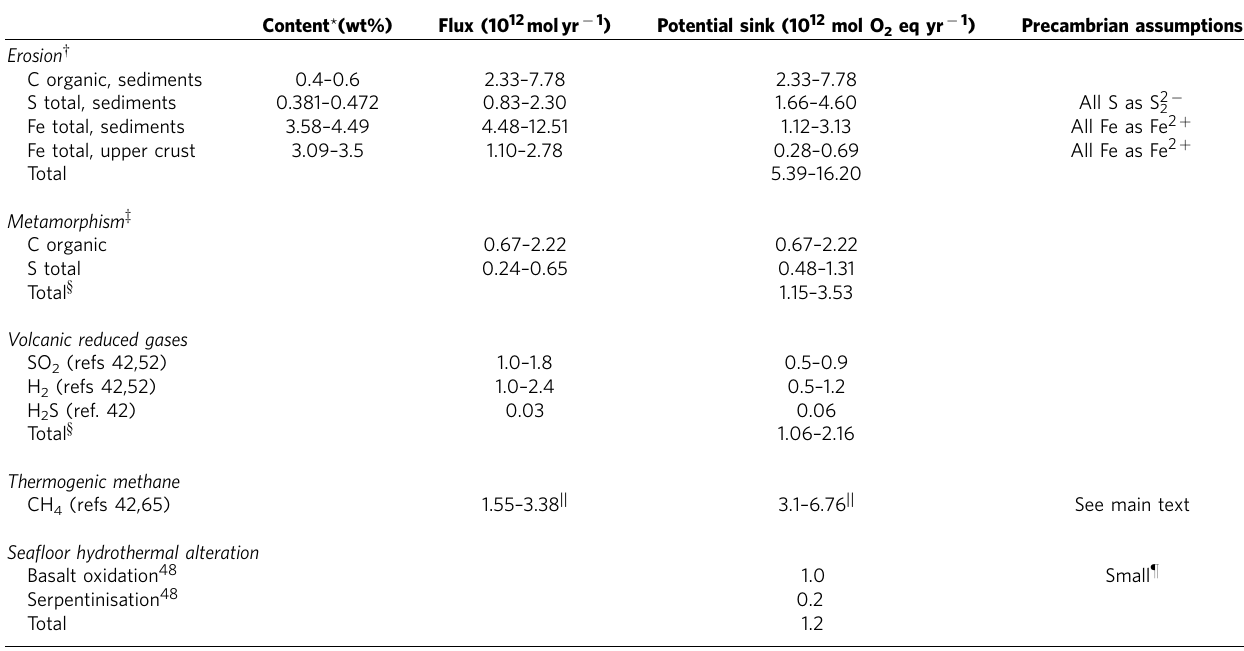
Table 1 | Potential oxygen sinks based on modern-day